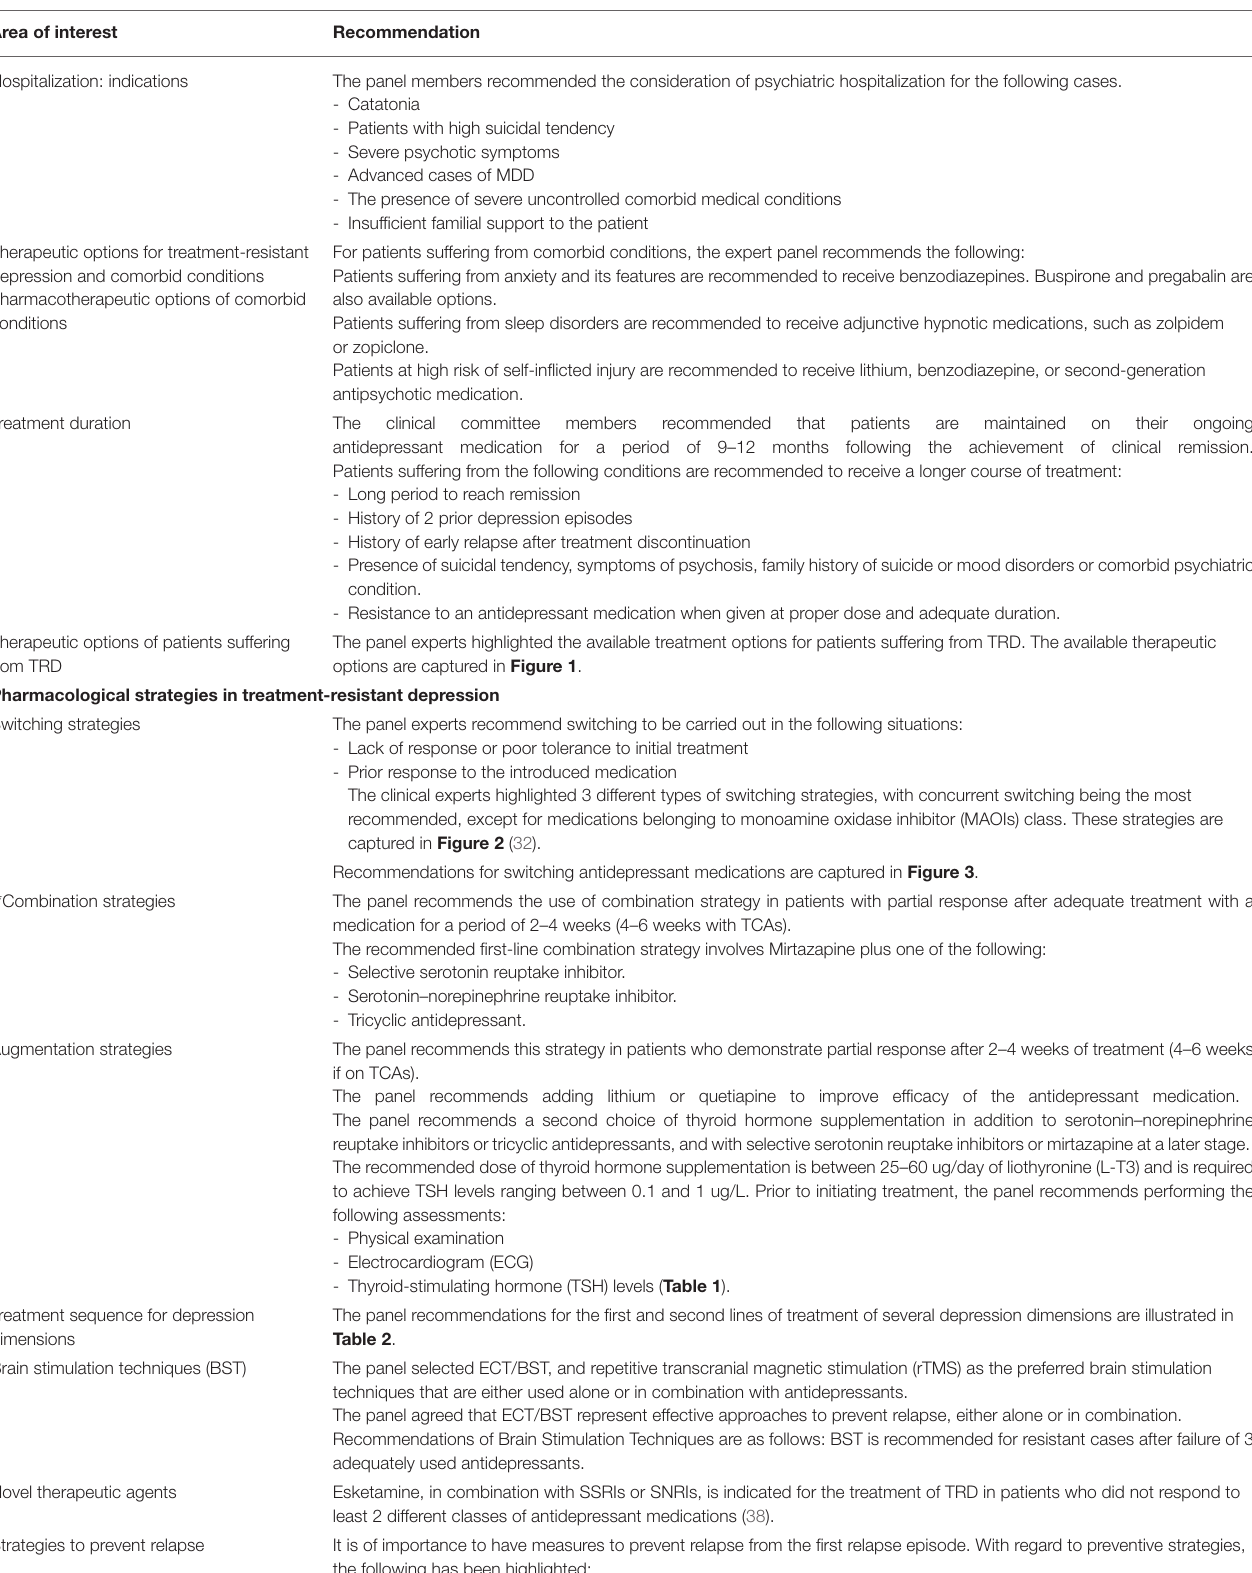
TABLE 3 | The main findings of this